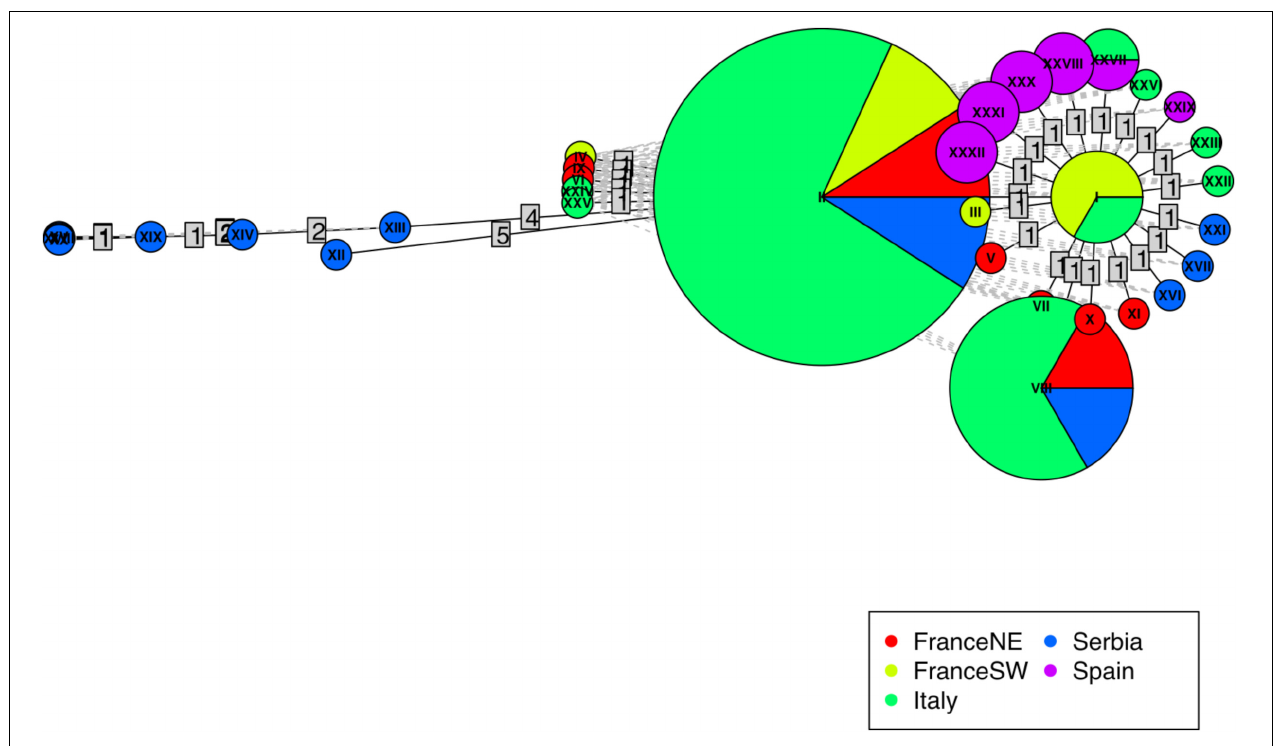
FIGURE 2 | Haplotype network of the 32 Ulmus laevis haplotypes computed using R package “pegas.” Circles are colored according to the provenance of haplotype from different geographic areas. The size of the circles is proportional to the frequencies of each haplotype across all populations. Lines represent the mutational steps between haplotype